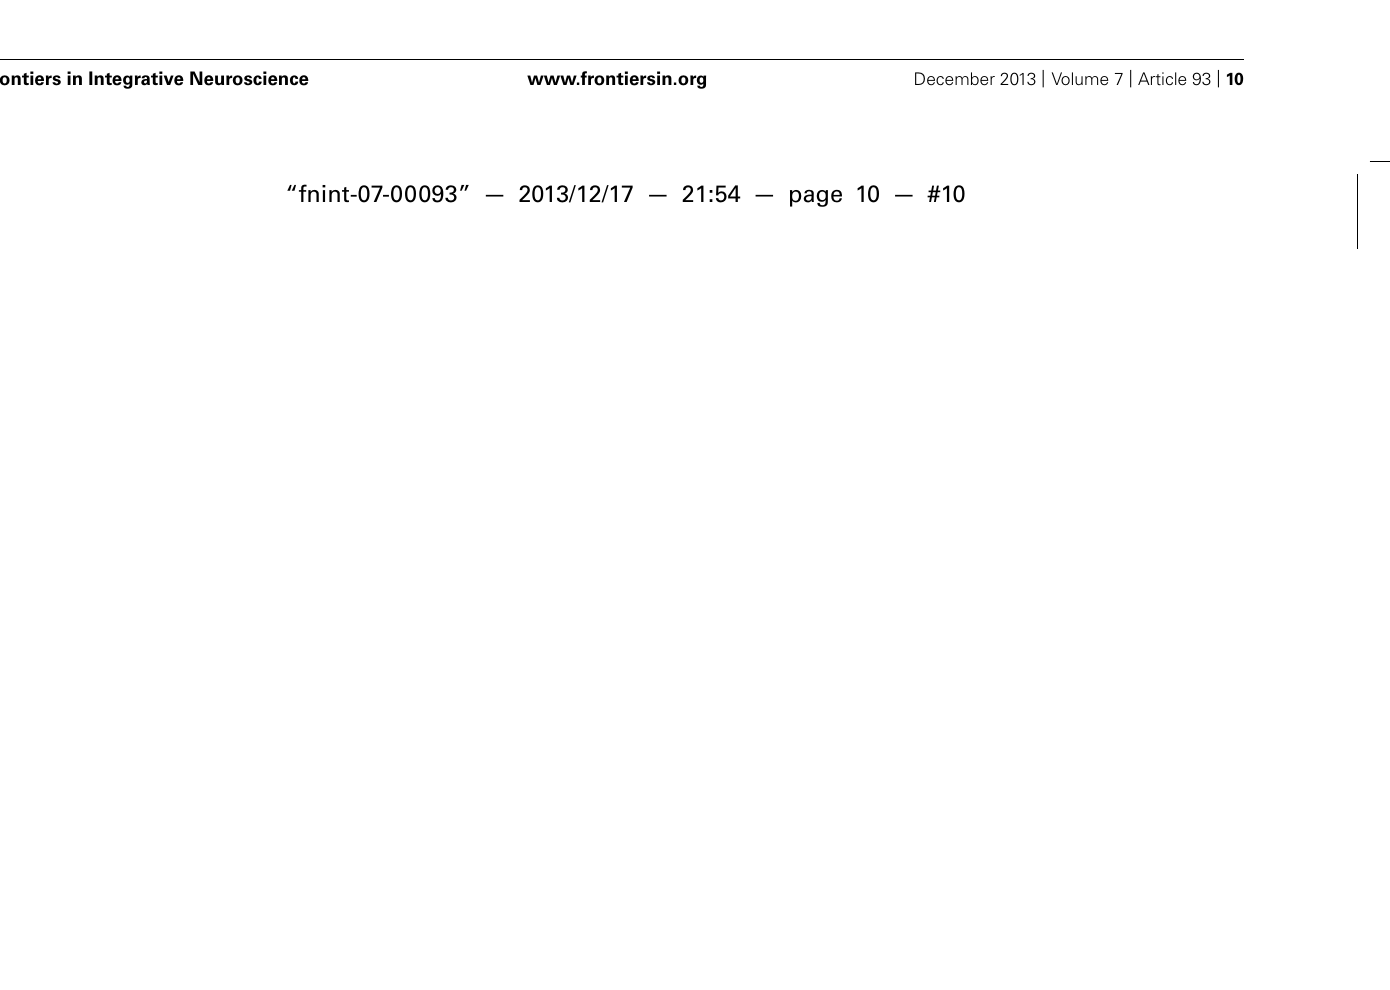
depolarization in the presence (square symbols) and absence (circles) of MAGL inhibitor JZL184 in female (left panel) and male (right panel) LH rats is plotted. GABA A IPSCs amplitude was normalized to the averaged value (dotted line) before depolarization. Each symbol represents the averaged value obtained from different cells. (C,D) Bar graphs summarizing the enhancing effect of JZL184 on DSI magnitude at both rostral (5 s; C ) and caudal (0.5 s; D ) afferents onto DA cells in male LH rats. Note that DSI at both inhibitory afferents in males is no longer different from DSI in females as measured during vehicle bath application. Data are expressed as mean ±